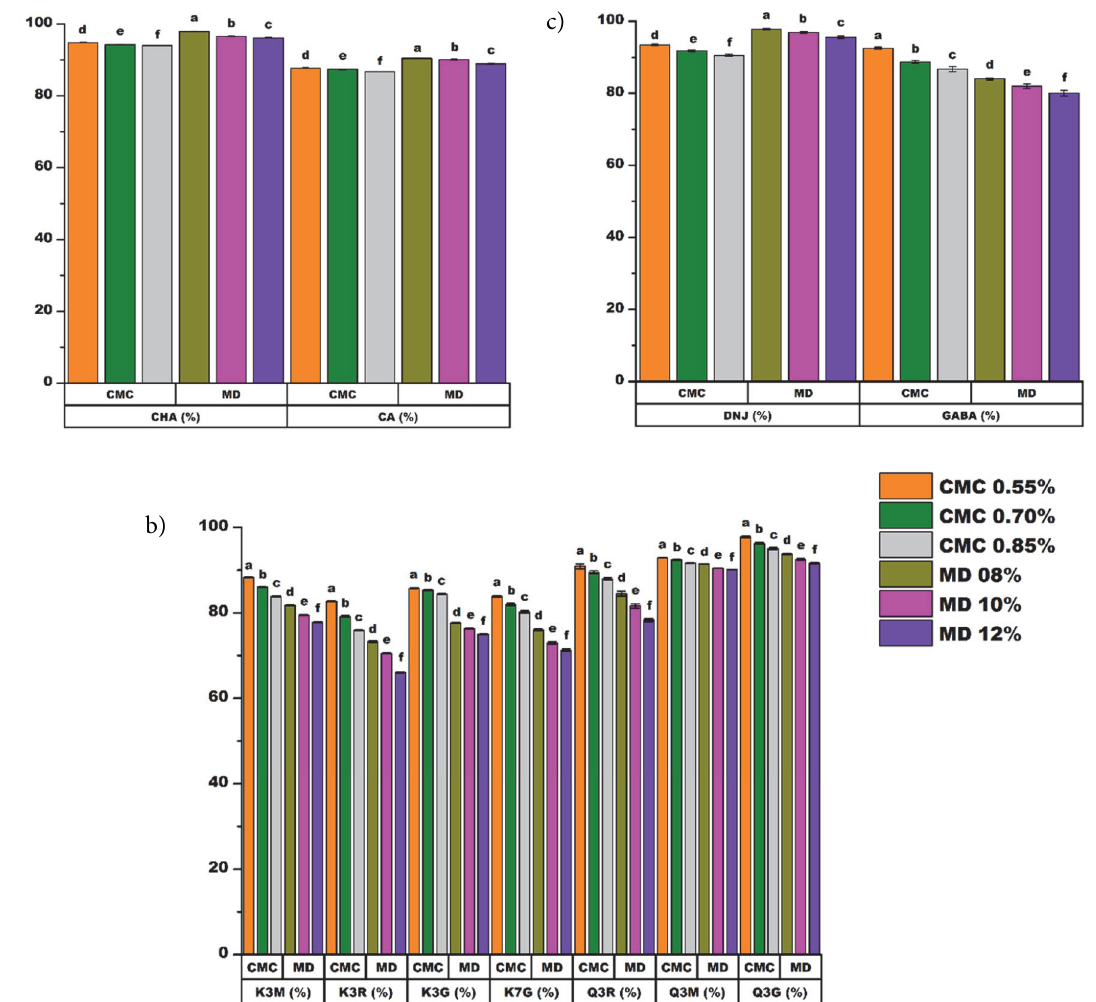
Figure 1 . Phenolic acids (a), flavonols (b), and other nutraceutical compounds (c) retention of encapsulated freeze-dried mulberry leaf extract powders CHA-chlorogenic acid, CA-caffeic acid, K3G-kaempferol-3-glucoside, K3M-kaempferol-3-(6-malonylglucoside), K3R-kaempferol-3-(6-rhamno- sylglucoside), K7G- kaempferol-7-O-glucoside, Q3G-quercetin-3-O-glucoside, Q3M-quercetin-3-(6-malonylglucoside), Q3R-quercetin-3-ru- tinose, DNJ-1-deoxynojirimycin, GABA-gamma-aminobutyric acid, CMC- sodium carboxymethyl cellulose, and